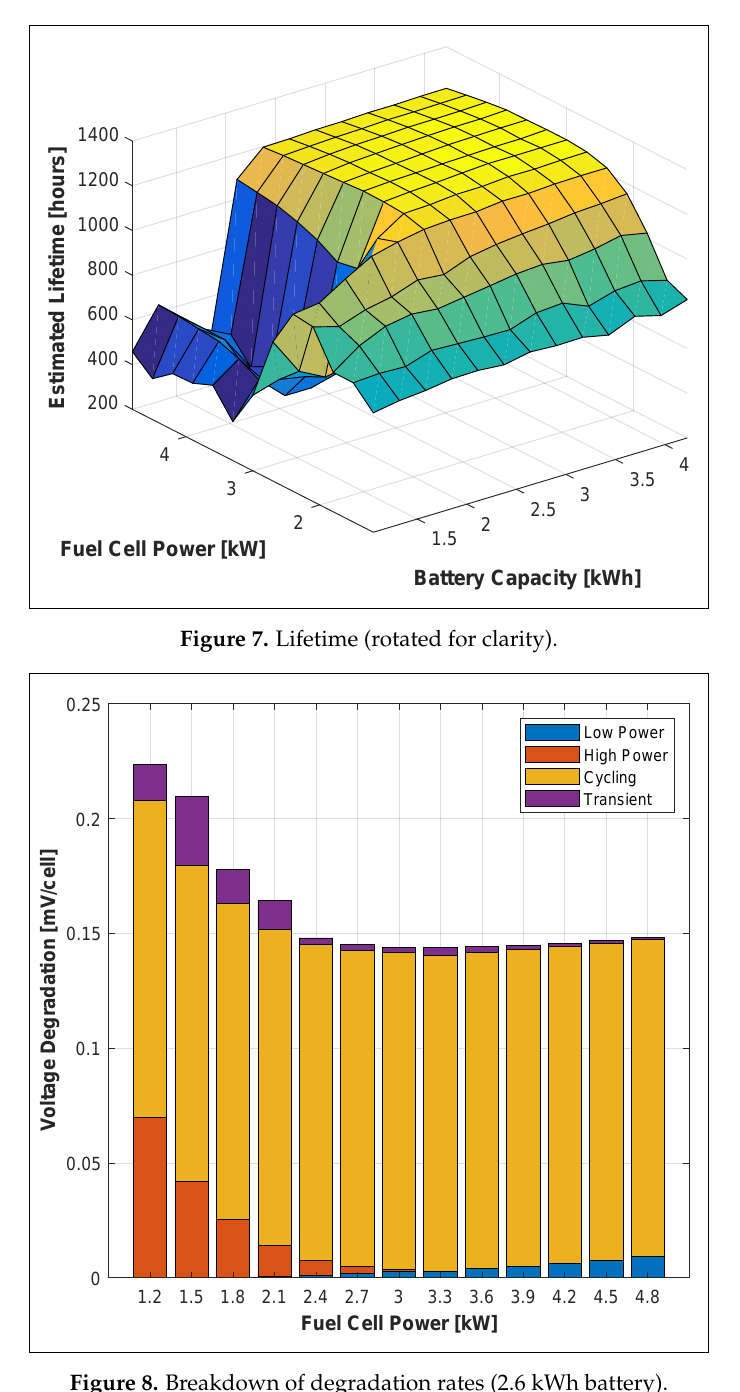
Figure 8. Breakdown of degradation rates (2.6 kWh